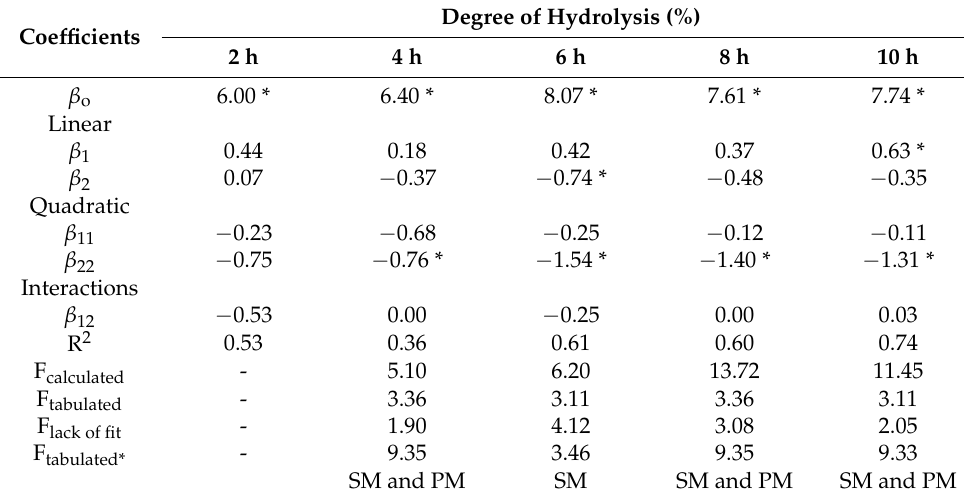
Table 3. Enzymatic hydrolysis—Regression coefficients and analysis of variance (ANOVA) for response